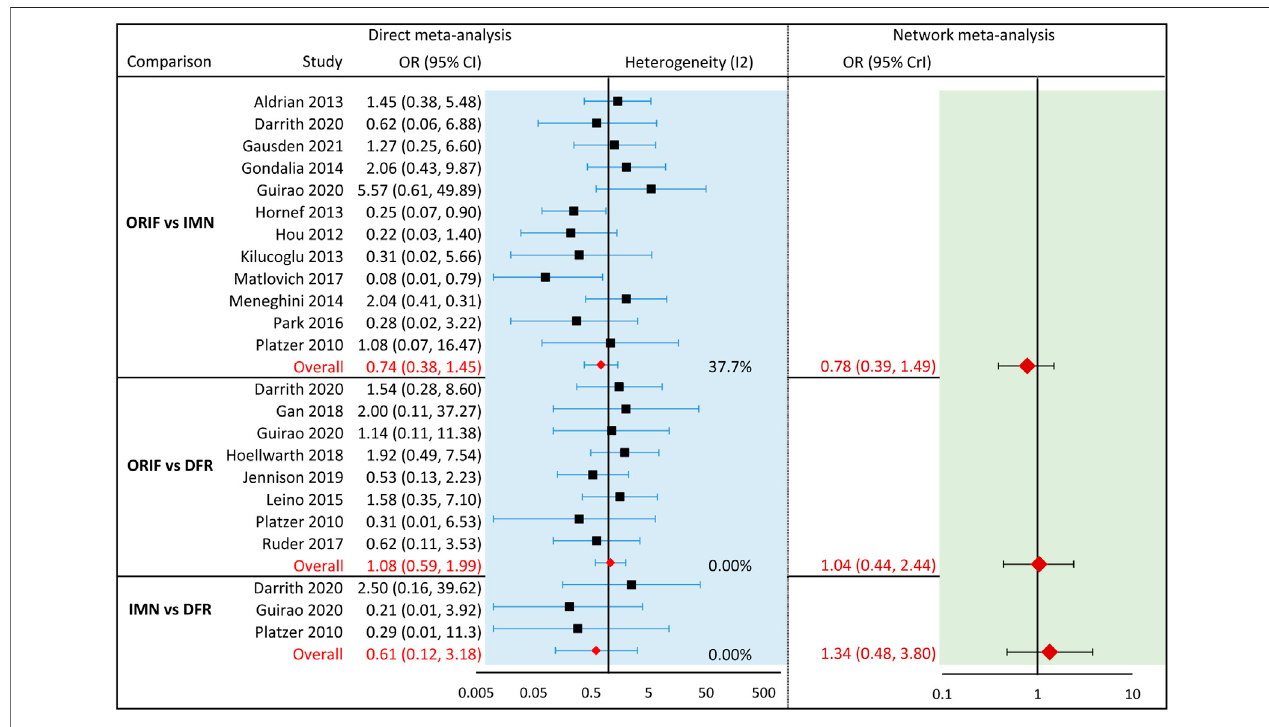
FIGURE 3 | Meta-analysis of major complications.